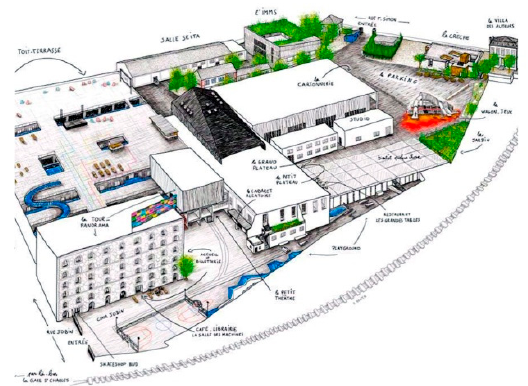
Figure 3. The image is from La friche instagram account. It is a work of art by the artist Emmanuelle Bentz (a Friche resident), prepared for La Friche